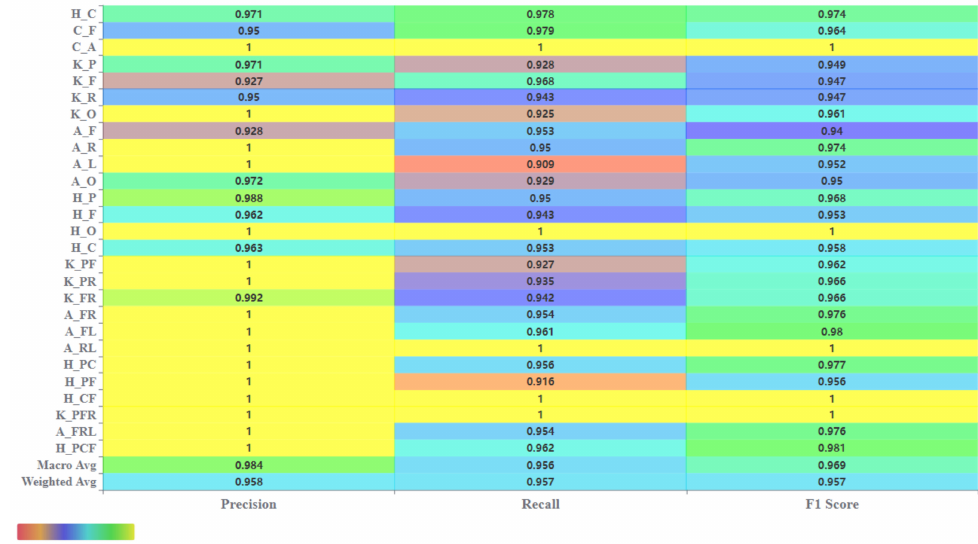
Figure 13. Class Level Precision-Recall and F1 score heatmap (Higher score denotes better model confidence in